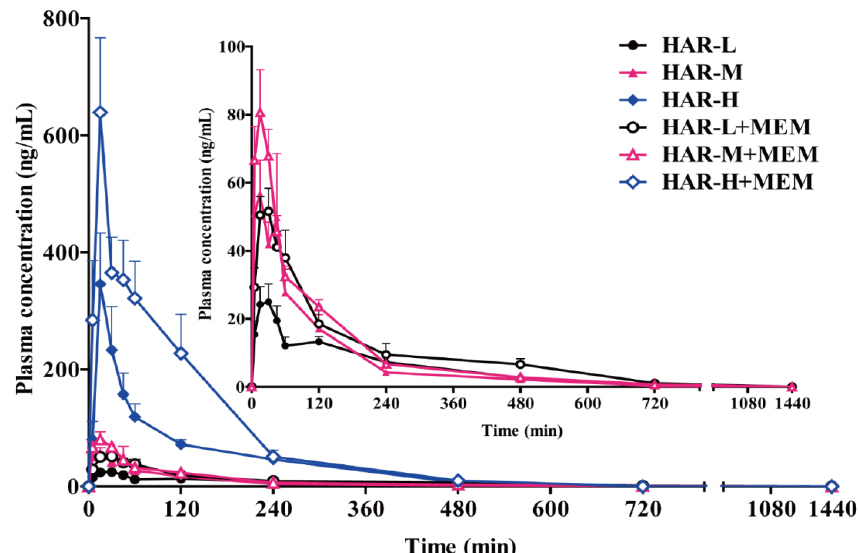
Figure 4. Mean plasma concentration time curves of HAR in rats plasma after oral administration of low (20.0 mg/kg), medium (40.0 mg/kg) and high (80.0 mg/kg) doses of HAR and low (20.0 mg/kg), medium (40.0 mg/kg) and high (80.0 mg/kg) doses of HAR combined with MEM (5.0 mg/kg) (n = 8, mean ± SEM).